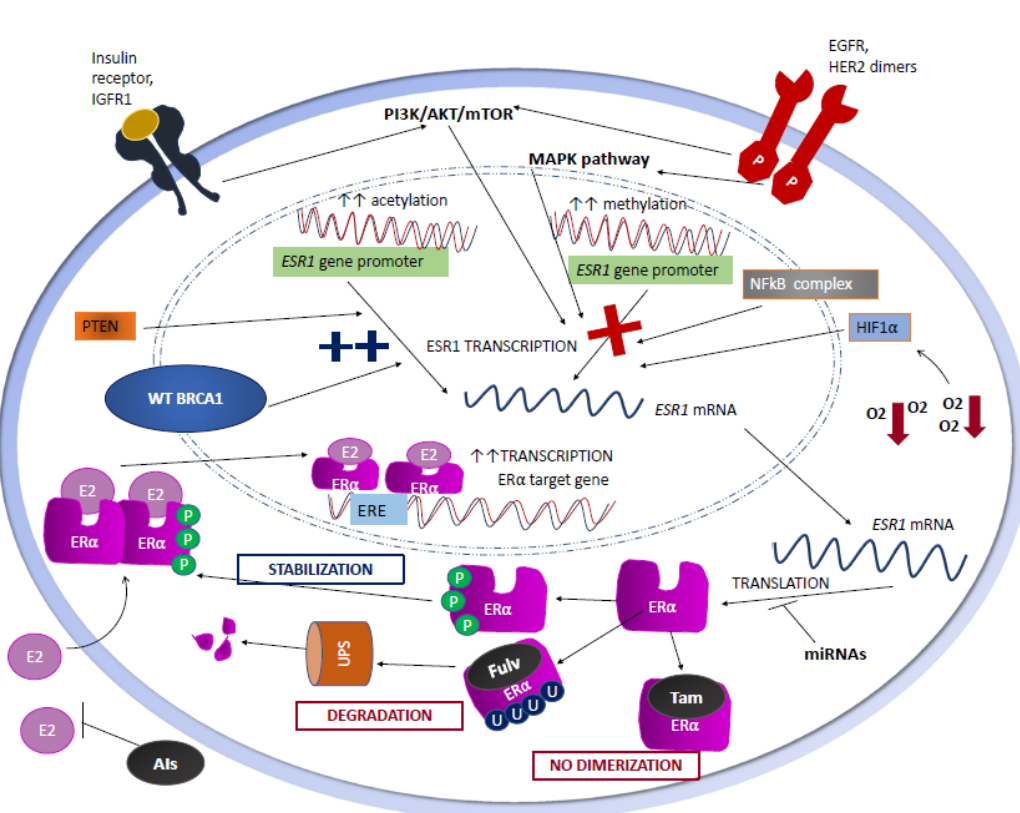
Figure 1. Mechanisms that regulate ESR1 transcription, ESR1 mRNA translation, and ER α post-translational modifications in HR + BC cells. BRCA1: Breast Cancer Type 1 susceptibility protein; E2: estradiol; ER α : estrogen receptor alpha; ERE: estrogen responsive element; AIs: aromatase inhibitors; Fulv: fulvestrant; miRNAs: microRNAs; P: phosphate group; PTEN: phosphatase and tensin homolog; Tam: tamoxifen; U: ubiquitin; UPS: ubiquitin proteasome system.